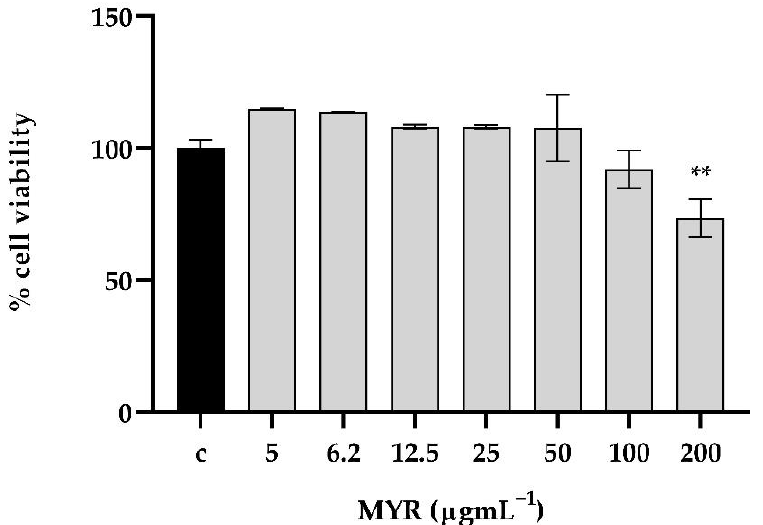
Figure 8. MTT assay after 24 h of exposure MYR (from 5 to 200 µ g mL − 1 ). MYR inhibited HaCAT cell proliferation at 200 µ g mL − 1 if compared to control (0.01% DMSO, 0.004% Tween 20). ** = p < 0.01 (Dunnett’s test).